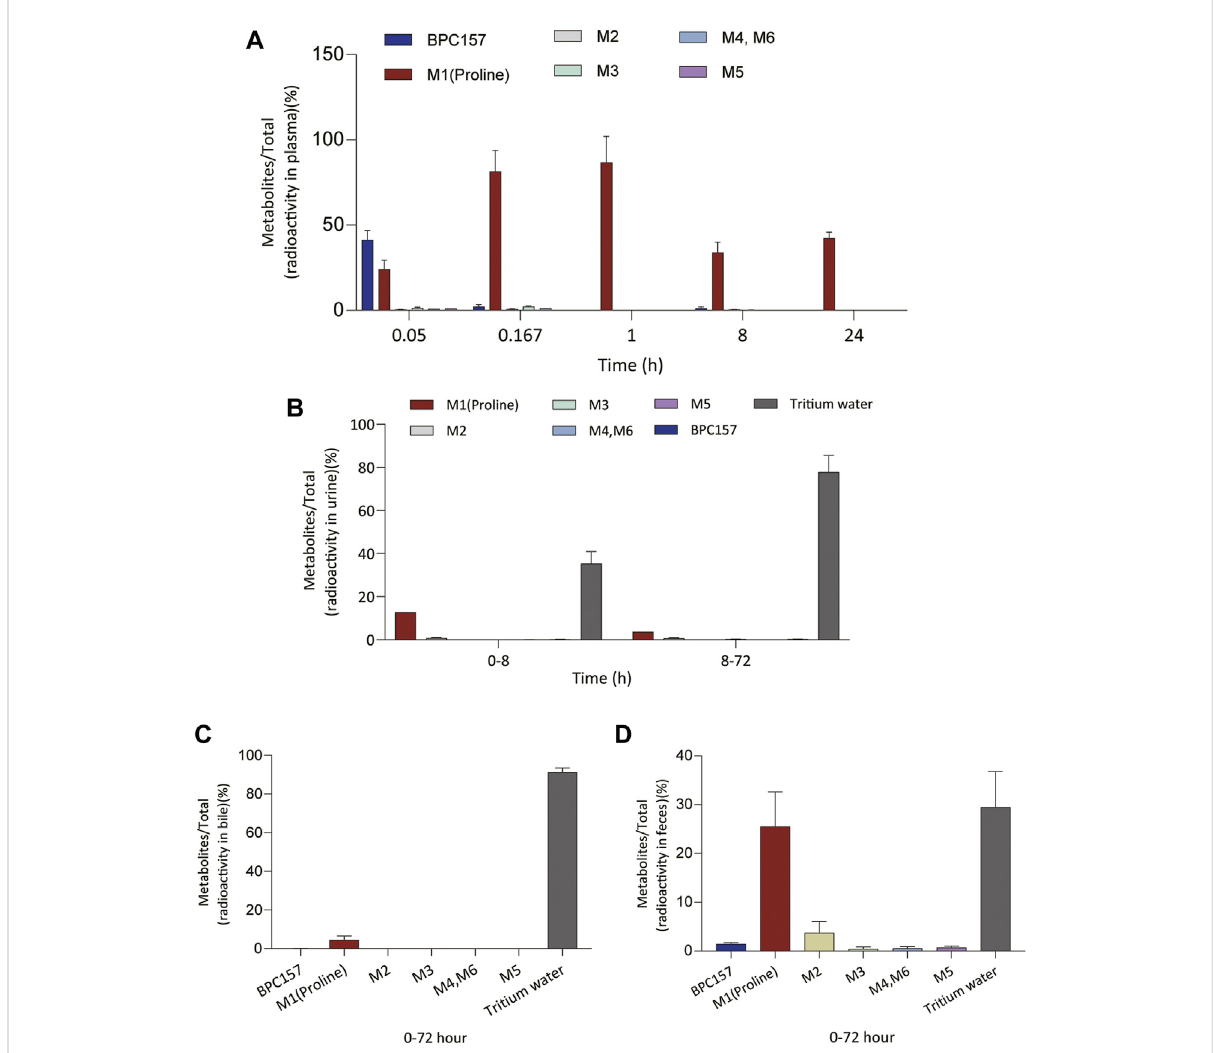
FIGURE 5 Changes in the proportion of six metabolites (M1 ‒ M6) with time in plasma (A) , urine (B) , bile (C) , and feces (D) after a single intramuscular administration of 100 µg/300 μ Ci/kg of [3H]BPC157 in rats (mean ± SD, n = 6). Data are representative of three independent